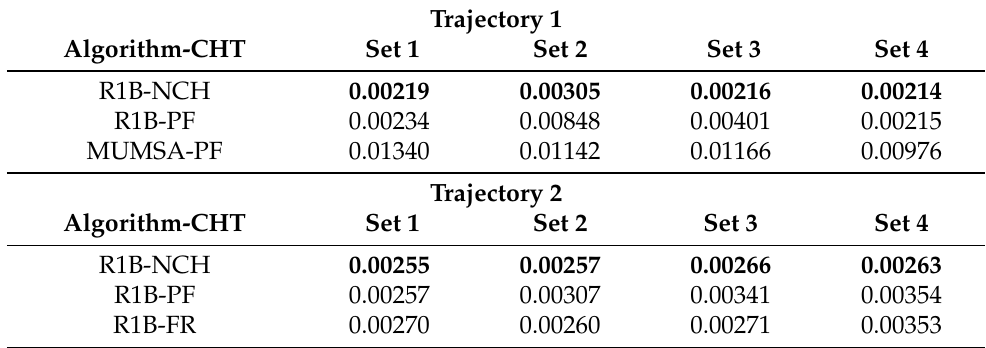
Table 11. Minimum value of the objective function through different sets of thirty algorithms’ executions in study case 1 in both